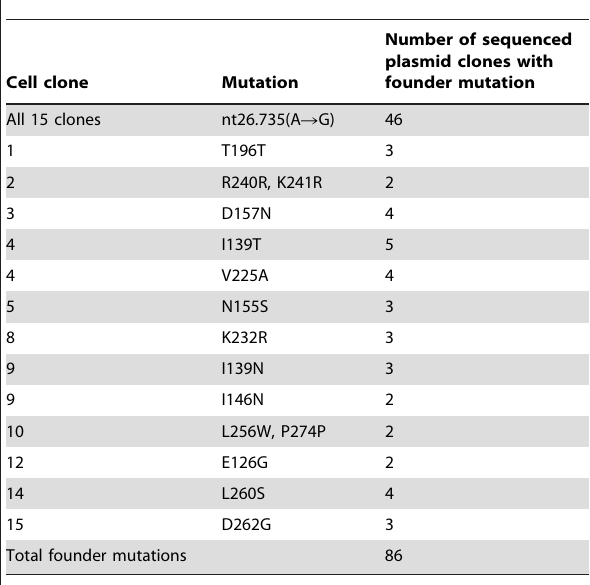
Table 5. Founder mutations in single cell KRC/Y